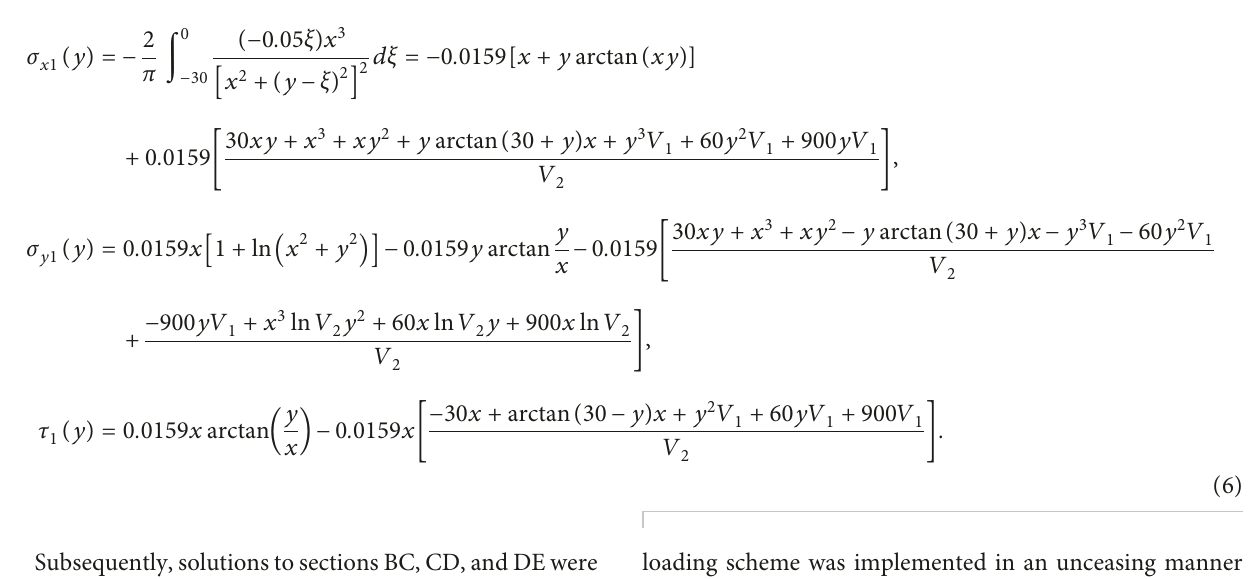
Figure 4: Bearing pressure distribution of the floor upon confined